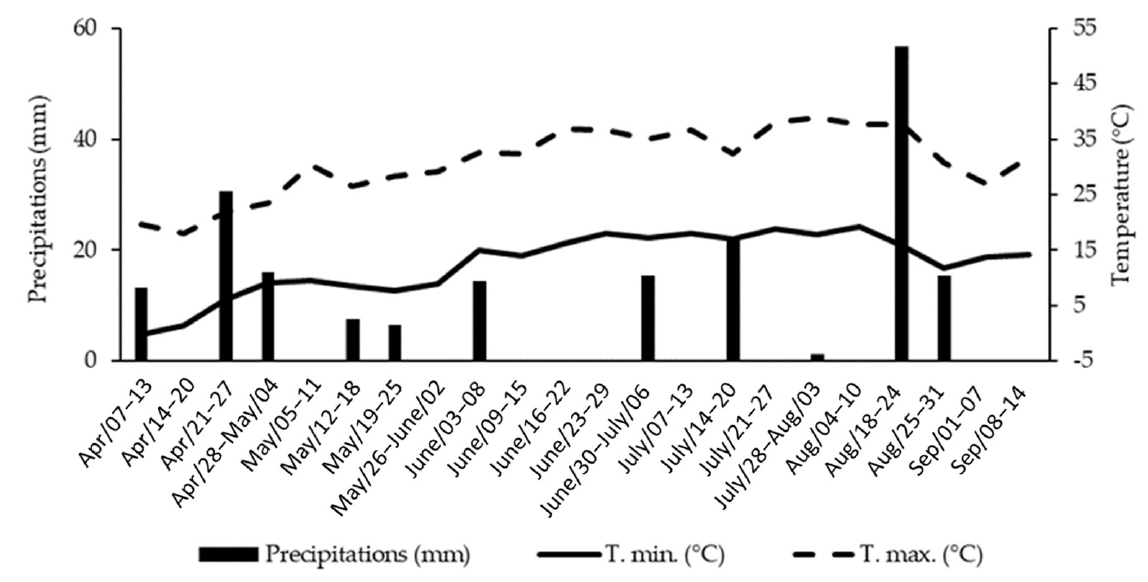
Figure 9. Meteorological trend during 2021 in Arcevia. Data were obtained from the weather station of Arcevia (AN), 295 m above sea level and recorded from April to September. All the data were provided by the Notiziario Agrometeorologico , published by Agrometeo ASSAM, Marche Region, Italy.